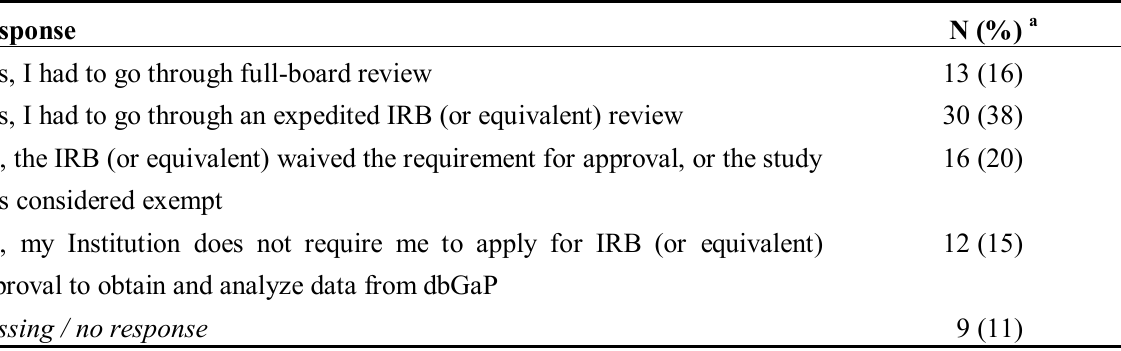
Table 4. IRB application experience for individuals requesting dbGaP